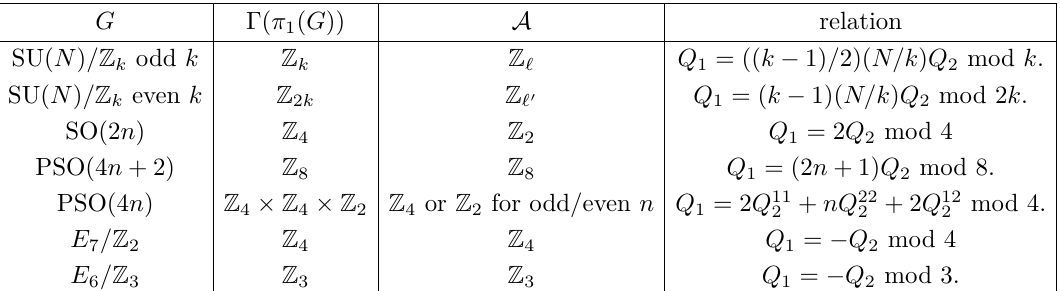
( G ))) / A . In the fist row 1